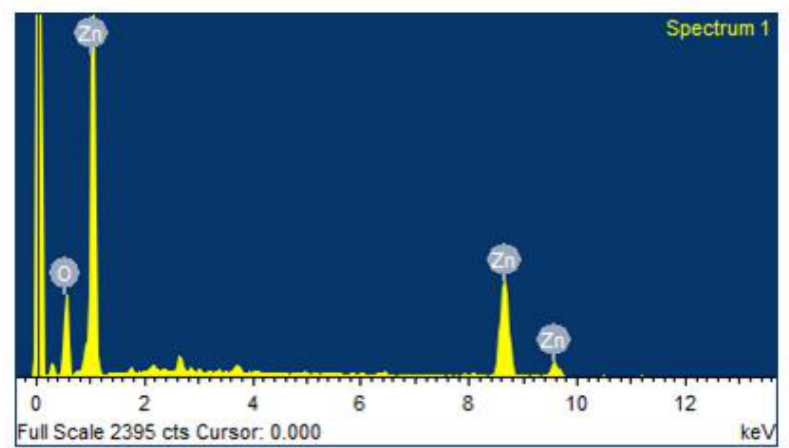
Figure 5. EDAX spectrum of ZnO NPs.